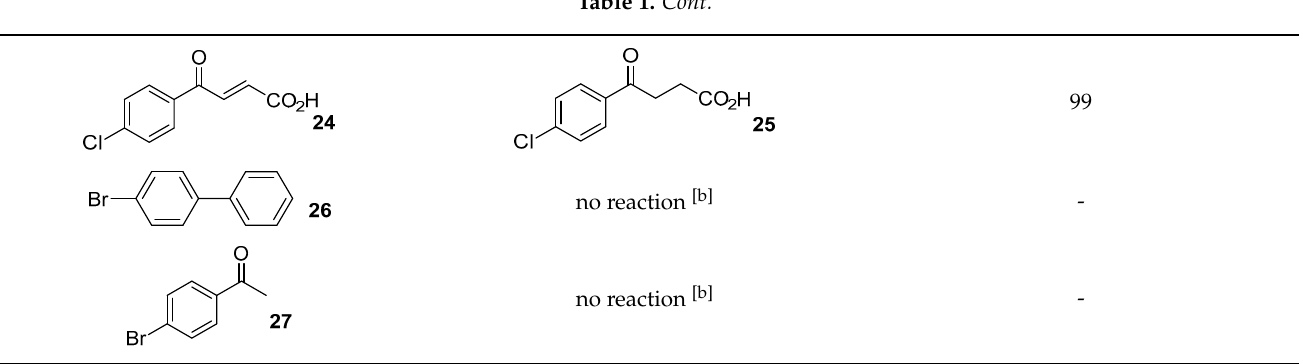
Table 2. Application to Benzyl Ester and N -Cbz Protective Group.